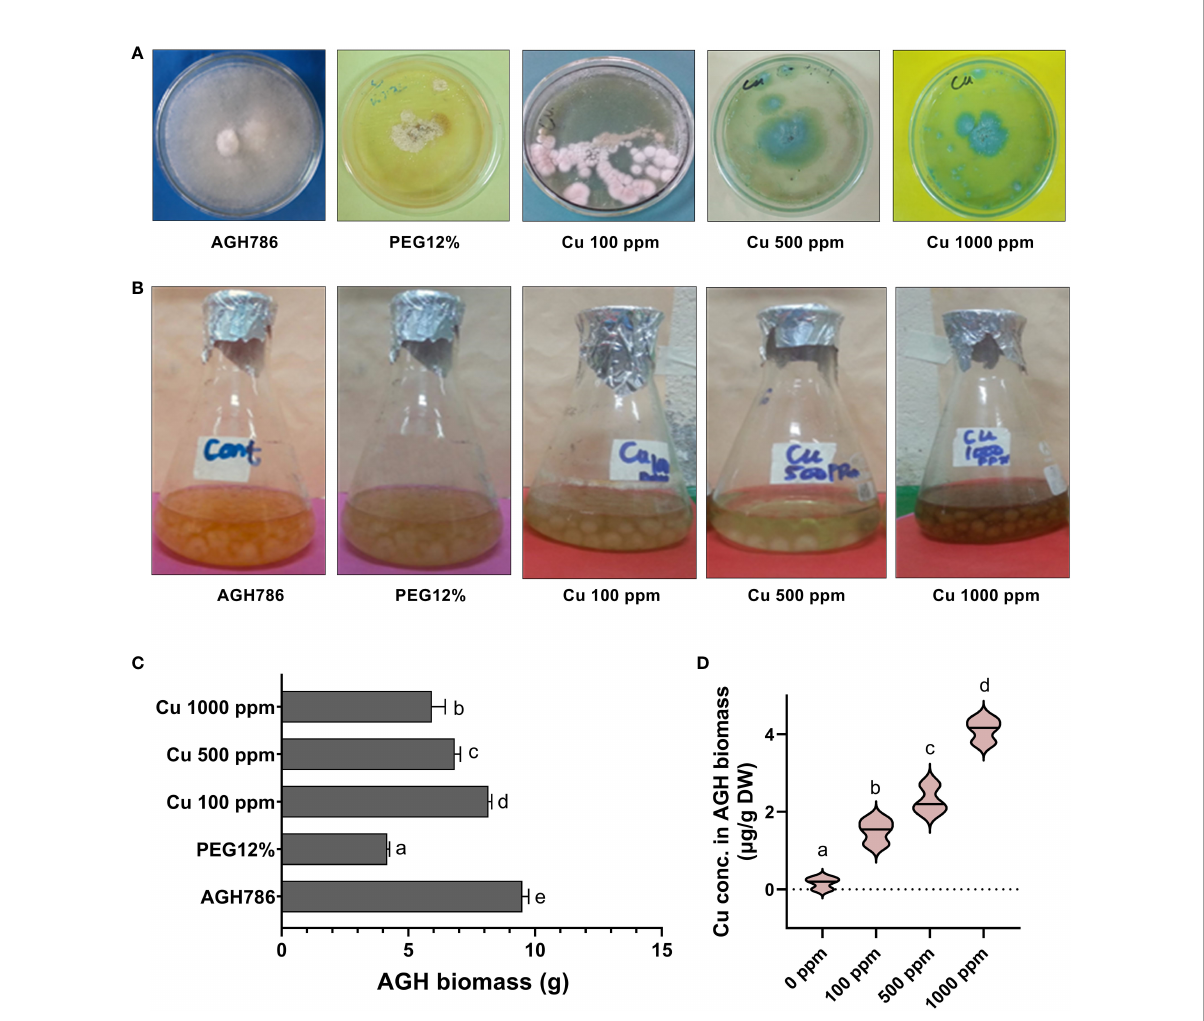
FIGURE 1 (A) Growth of P. spadiceum AGH786 on different concentrations of Cu and 12% PEG on solid media. (B) Growth of P. spadiceum AGH786 on different concentrations of Cu and 12% PEG on liquid media. (C) Fresh weight of P. spadiceum AGH786 on different concentrations of Cu